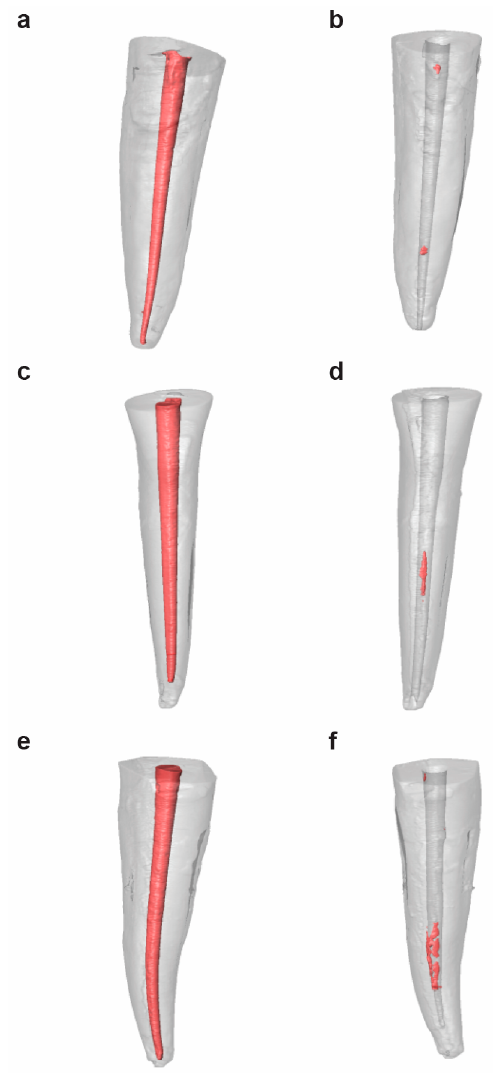
Figure 1. Reconstructed three-dimensional micro-computed tomography (micro-CT) images before ( A , C , E ) and after ( B , D , F ) non-surgical endodontic retreatment, according to the non-surgical endodontic retreatment techniques.